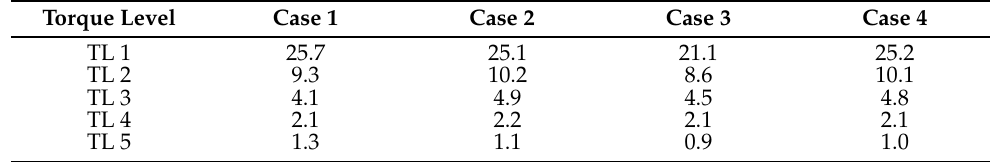
Table 10. The distance of walking (kilometres).